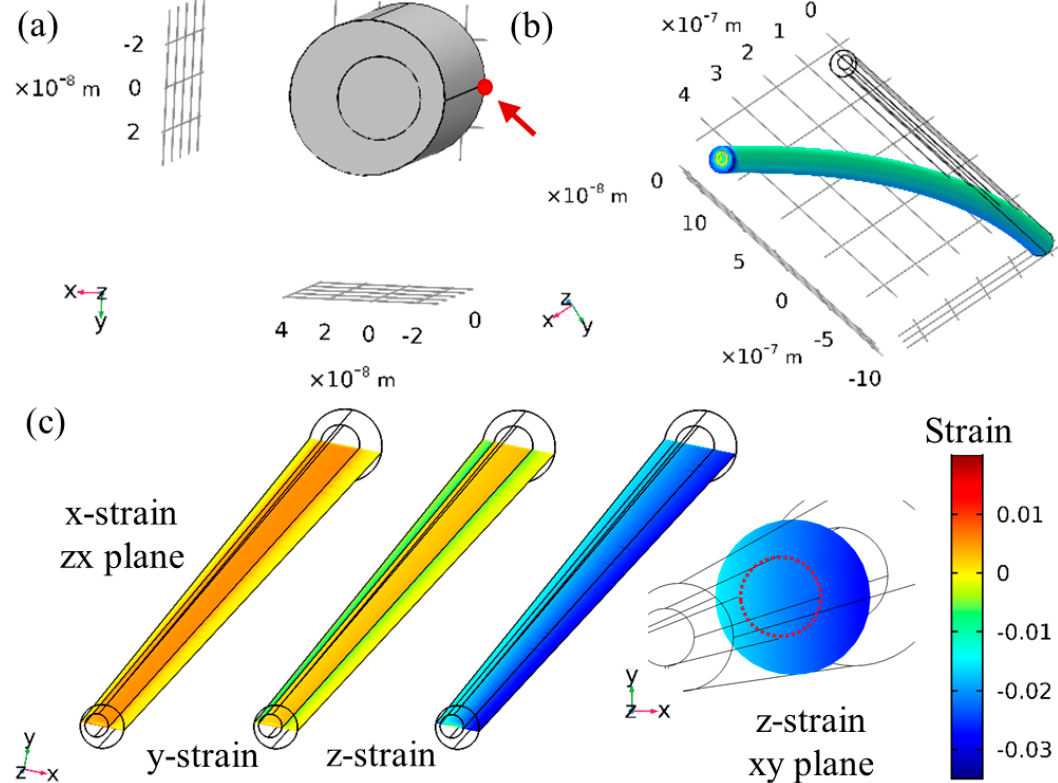
Figure 5. COMSOL simulation of the asymmetric shell-induced bending. ( a ) Top view of the geometry; ( b ) relaxed (bent) NW, where displacement of the top was nearly 0.5 µm. The red point and arrow mark the clamping in the point-clamped case; ( c ) strain analysis of the simulated results, i.e., the surface-clamped tapered case (grey tinted row in Table 1). The left-hand side shows x,y,z strains throughout the central ZX cross section, and the right-hand side shows the axial (z) strain throughout an XY cross section, with a dashed circle guiding the eye to the InP core. Overall, the NW was axially compressed and slightly strained radially following Poisson’s ratio. The scale bar is common to all cross sections. Table 1. COMSOL results for the relaxed radius of curvature.